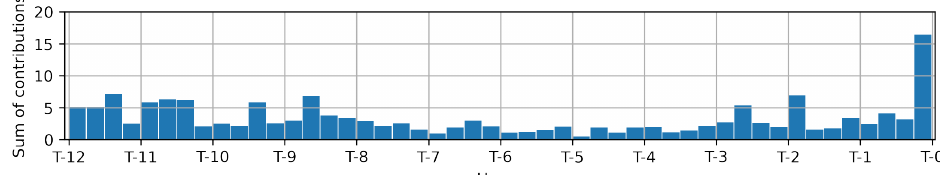
Figure 8. Temporal importance was calculated by averaging across all clinical variables and all clinical conditions in the test set. This measure reflects the degree of influence of each time point on the prediction. We observed that greater weight was given to the most recent and earlier measurements. This may indicate that the algorithms are able to capture changes in clinical variables over